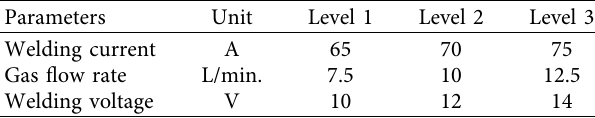
Table 2: Process parameters and their